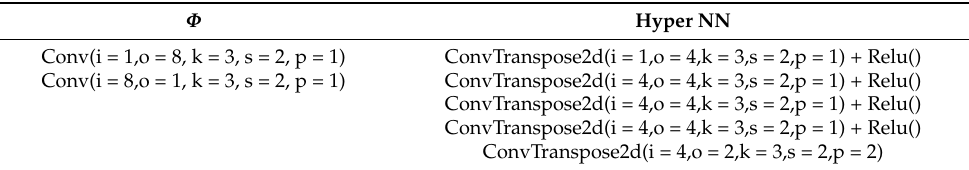
Table A4. HyperNN architecture parameters for convection–diffusion equation. Notations in